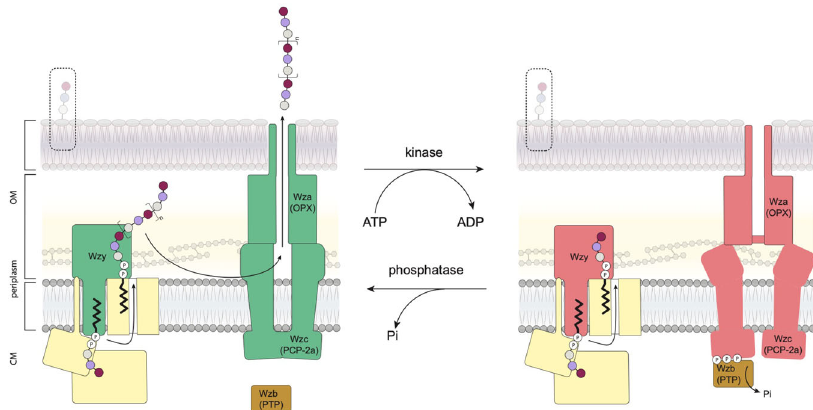
Fig. 6 Model for Wzc function. Wzc, the master regulator of capsule assembly and export regulates the activity of Wzy (polymerase) and opens Wza (translocon). Multi phosphorylated Wzc is found as a monomer whilst dephosphorylated Wzc forms an octamer. Capsule product and export requires continuous Wzc cycling between phosphorylation and dephosphorylation states. Polymer chain completion may be accomplished in a single or stepwise by multiple